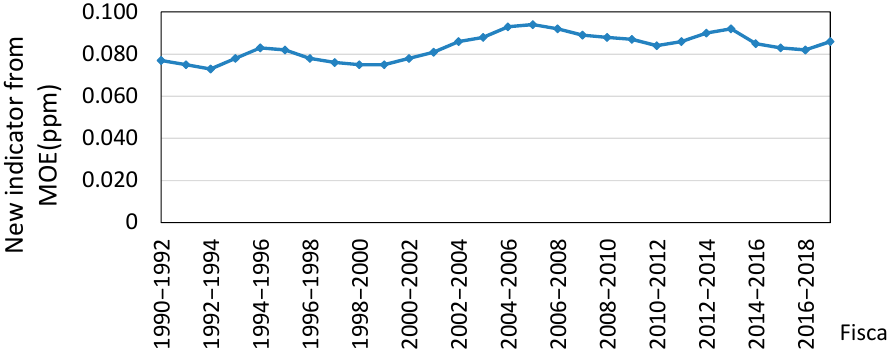
Figure 8. Trend in a new indicator from the Ministry of the Environment (MOE) (three-year moving average of the annual 99th percentile of the daily maximum for the eight-hour value). Ox concentration: calculation of annual 99th percentile of the daily maximum for the eight-hour value.